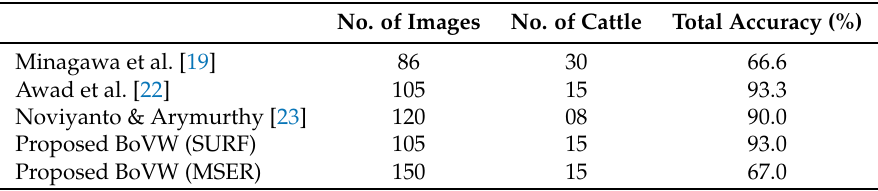
Table 3. Comparison of the obtained identification accuracies using the BoVW with SURF and MSER against other state-of-the-art